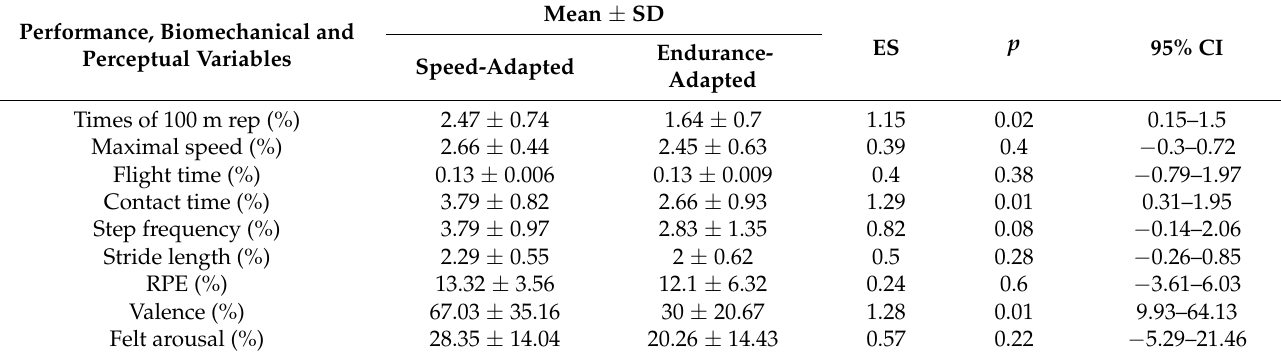
Table 2. Means and standard deviations (SD) of the coefficient of variation (CV%) of performance, biomechanical and perceptual variables collected to speed- and endurance-adapted milers. Effect sizes (ES), p -values and confidence intervals (95% CI) calculated from the comparison of these variables between